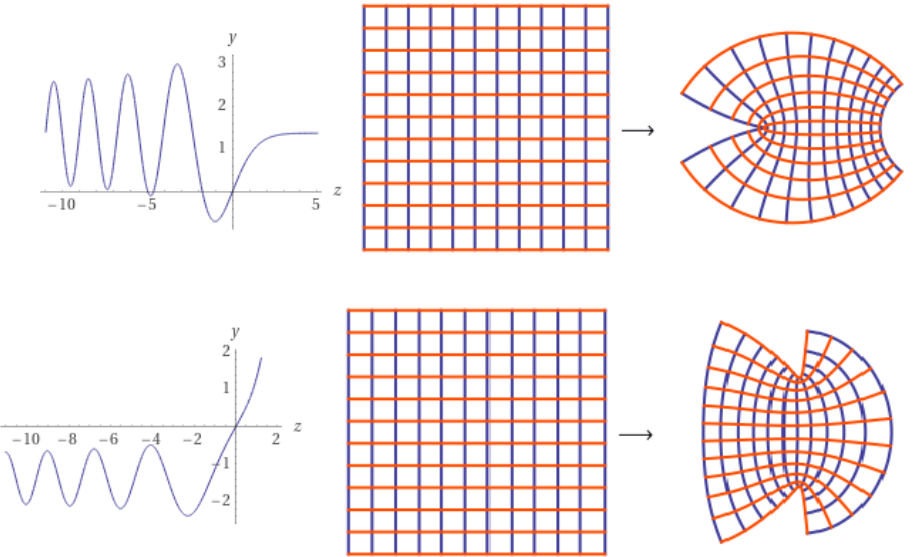
Figure 1. The graph of the normalized Airy functions Y 1 , Y 2 ,